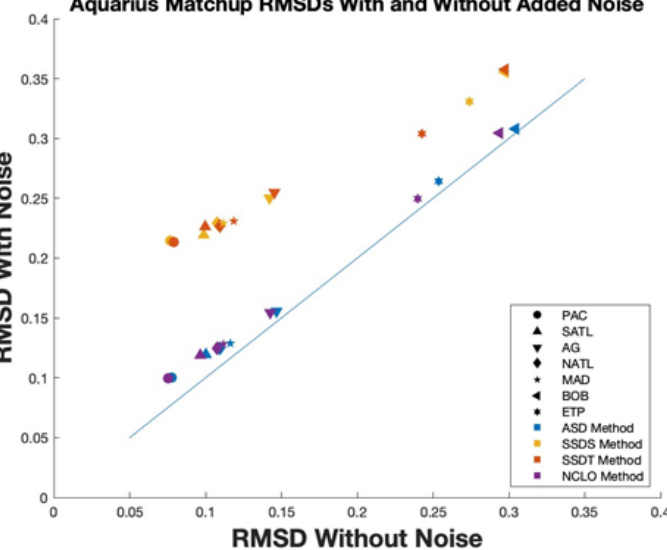
Figure 8. RMSD values produced using each method with the simulated Aquarius dataset and the simulated Aquarius data set with Gaussian noise (Standard Deviation = 0.2, Mean = 0) added.